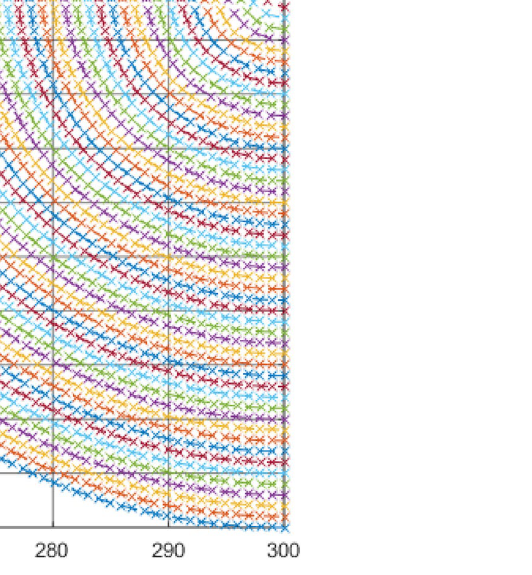
Figure 6. Quarter circle corners of a space point